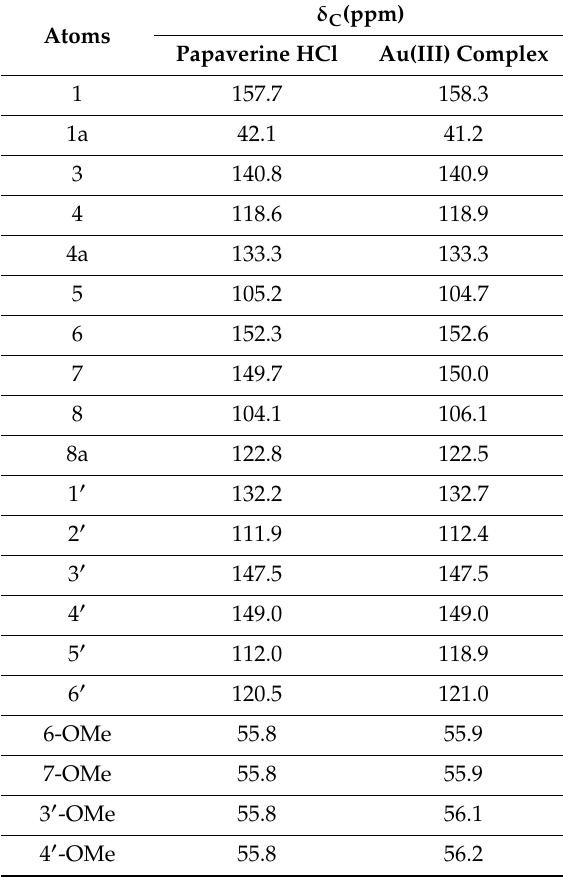
Table 4. 13 C-NMR characteristics of papaverine HCl and its Au(III) complex.